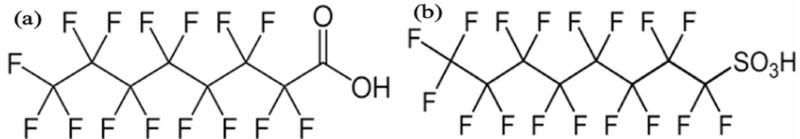
Figure 7. Molecular structures of ( a ) Perfluorooctanoic acid (PFOA) and ( b ) Perfluorooctane sulfonates (PFOS).